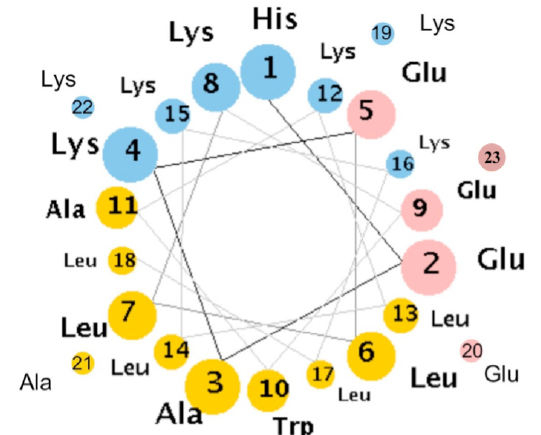
Figure 8. Helical Wheel for the model peptide system, where hydrophobic (yellow), basic (blue) and acidic (red) are